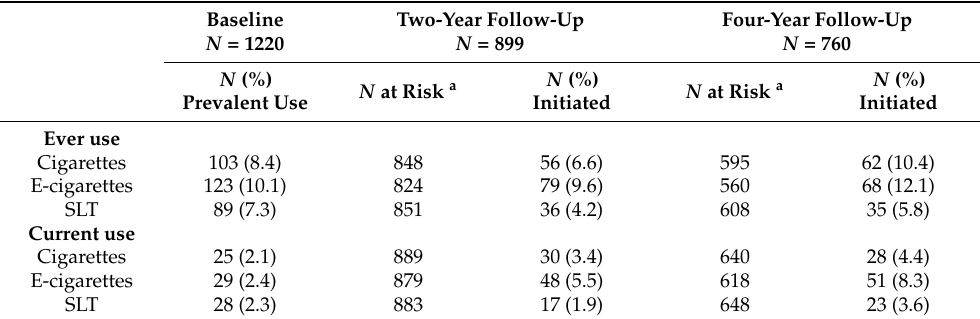
Table 2. Prevalence of tobacco use at baseline and incidence at two- and four-year follow-ups. Baseline Two-Year Follow-Up N = 1220 N =